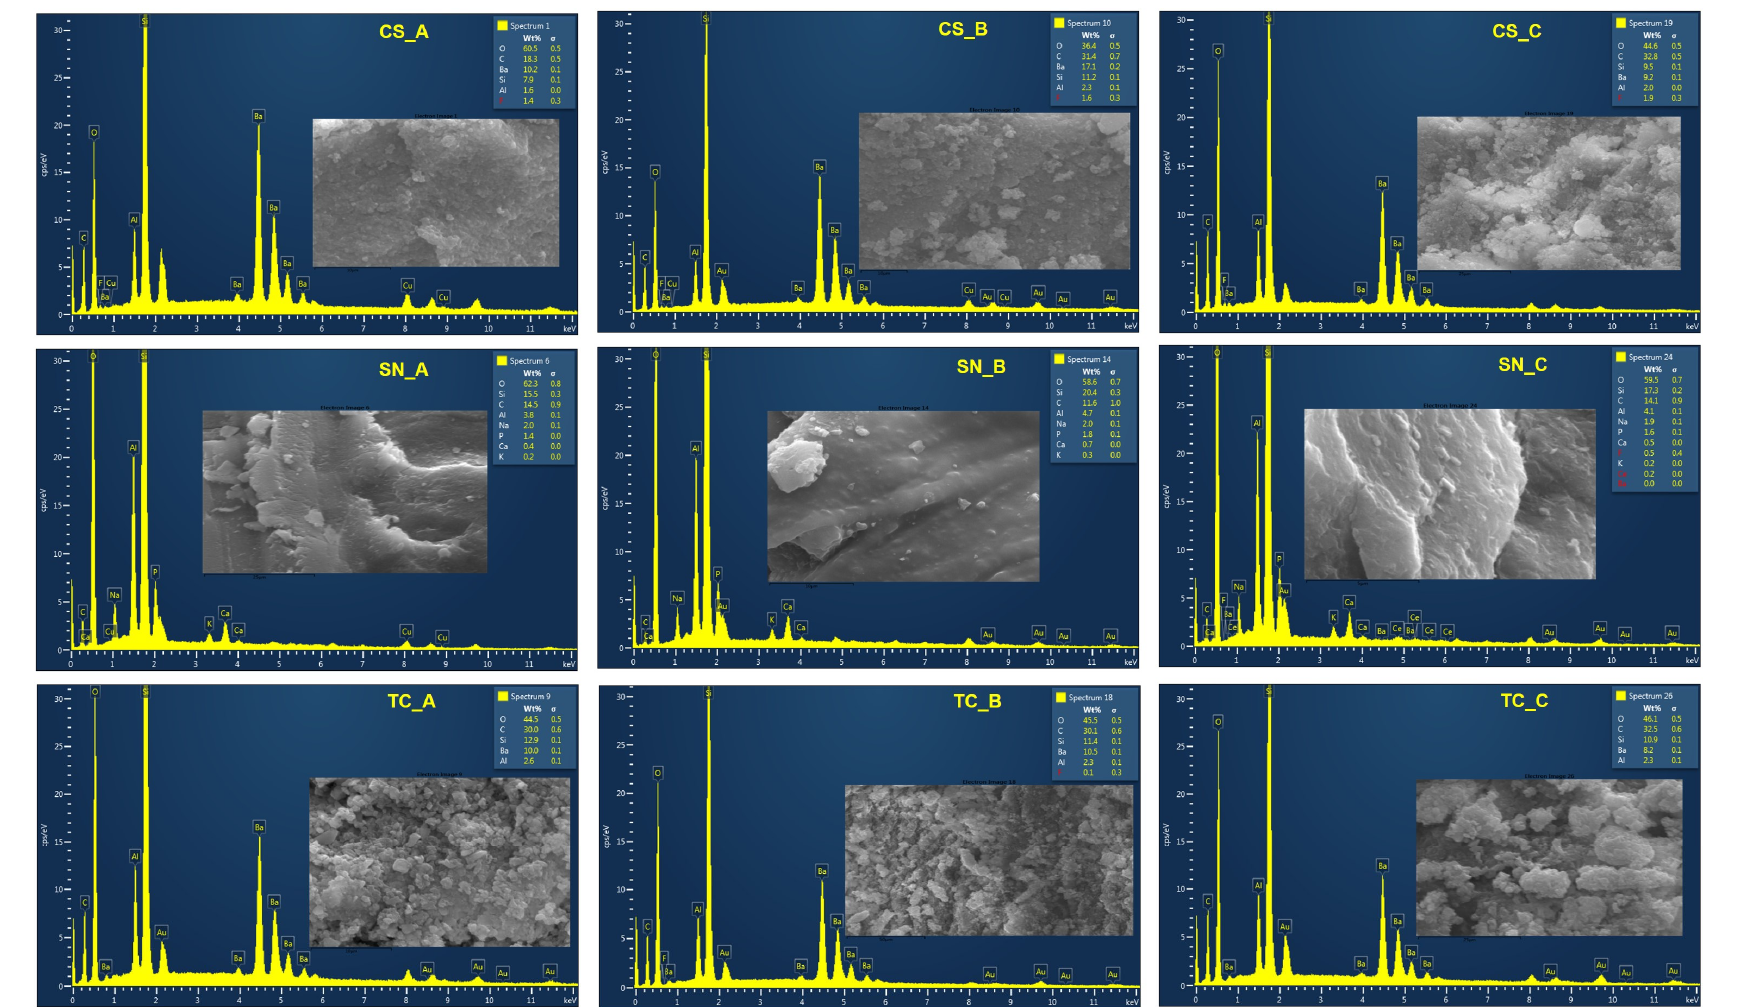
Figure 5. EDX spectra of the nonexposed/exposed CAD/CAM restorative materials powders to acidic artificial saliva.